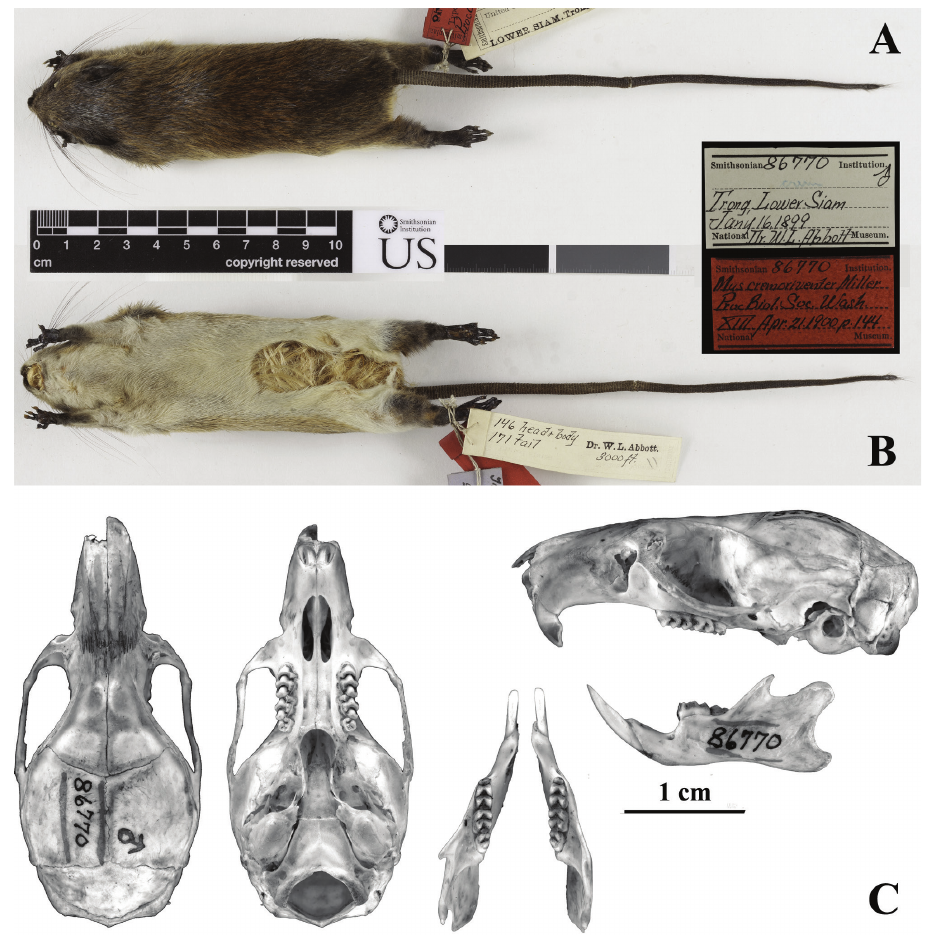
Figure 6. The holotype of Niviventer cremoriventer , stuffed skin and skull, USNM 86770. A Stuffed skin, dorsal view B Stuffed skin, ventral view; the natural coloration of front legs and feet is changed due to chemical treatment C Skull. Images were kindly provided by the National Museum of Natural History, Smithsonian Institution, Washington,